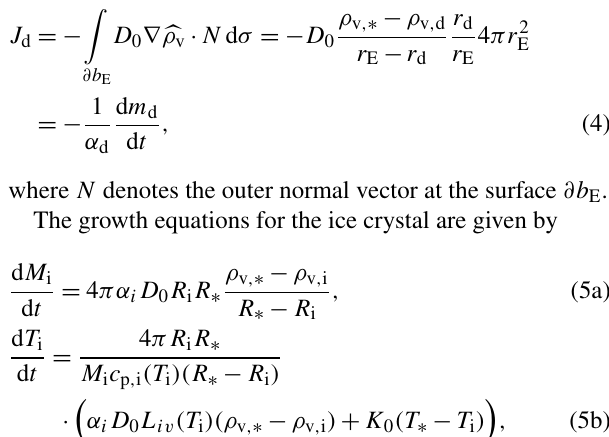
Figure 3. Illustration of the spherical shell obtained by extending the surface of the sphere with interaction radius R ∗ around the ice crystal. Within the gray shaded area representing the volume V S of the spherical shell, we assume a uniform distribution of water vapor and